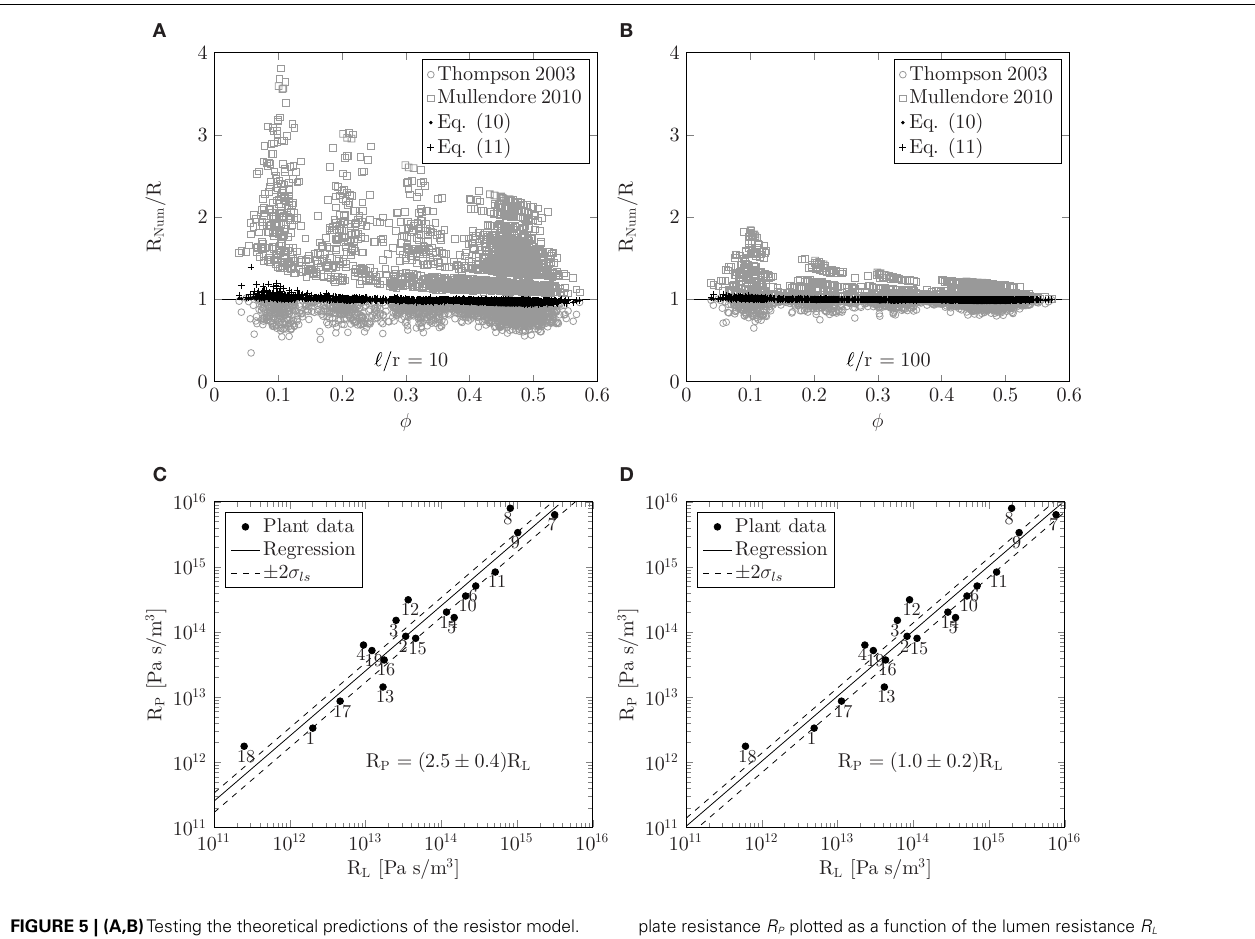
FIGURE 5 | (A,B) Testing the theoretical predictions of the resistor model. Resistance ratio R num / R plotted as a function of the covering fraction φ for (cid:96) / r = 10 (A) and (cid:96) / r = 100 (B) .The numerical resistance R num was determined from numerical simulations of flow in idealized sieve plates with circular pores for 1980 combinations of the parameters given in equation (12) covering the ranges given in Table 1 .The predicted resistance R was calculated from equations (10) and (11) and with the methods from Thompson and Holbrook (2003) and Mullendore et al. (2010), as described in Sec. 2.2. (C–D) Relationship between lumen and plate resistance.